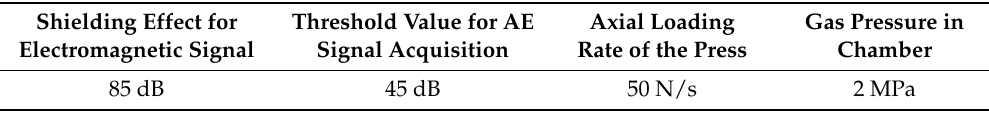
Table 1. Setting of experimental parameters.